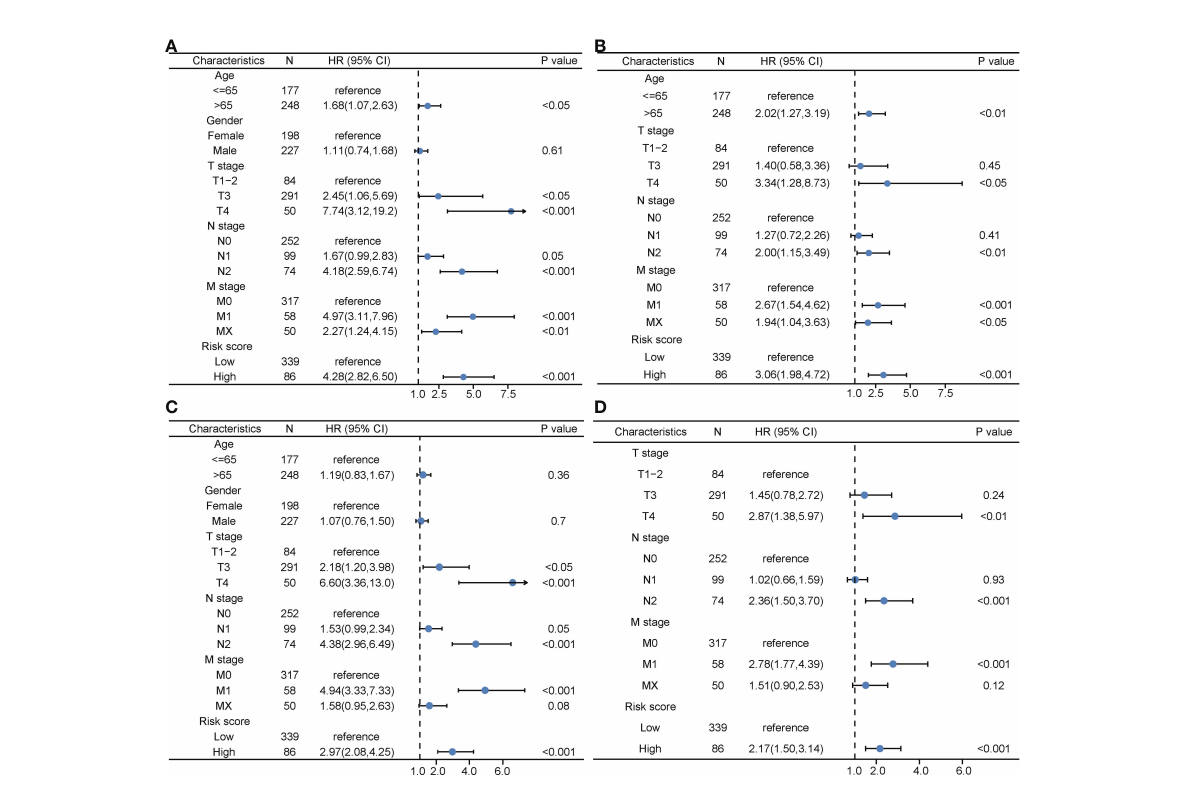
FIGURE 6 The prognostic value of clinical features and the risk score. (A) Univariate Cox regression analyses regarding OS in the TCGA cohort. (B) Multivariate Cox regression analyses regarding OS in the TCGA cohort. (C) Univariate Cox regression analyses regarding PFS in the TCGA cohort. (D) Multivariate Cox regression analyses regarding PFS in the TCGA cohort. OS, overall survival; TCGA, The Cancer Genome Atlas; PFS, progression-free